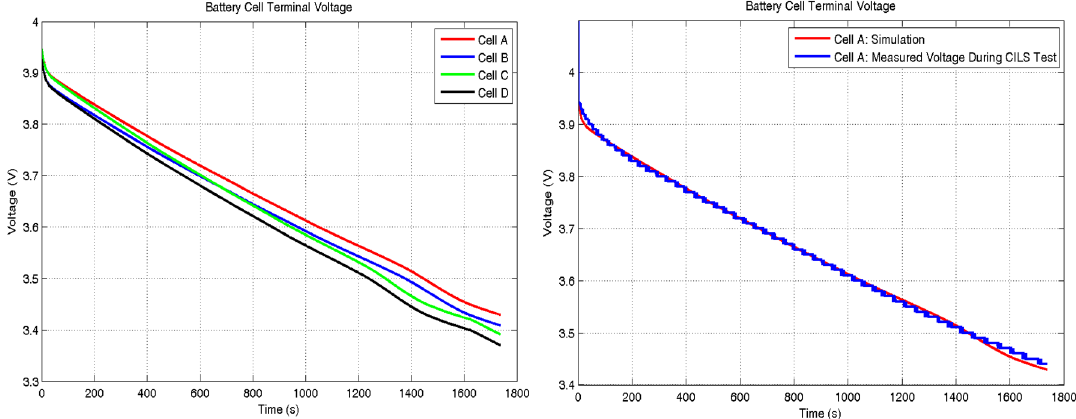
Figure 9. Terminal voltage of each cell under a 1 C constant current